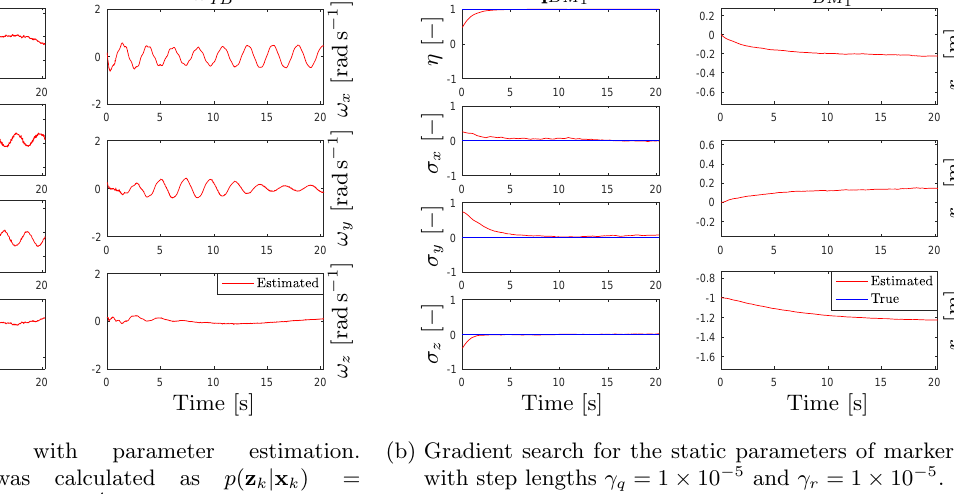
(a) Particle filtering with parameter estimation. (b) Gradient search for the static parameters of marker 1 with step lengths γ q = 1 × 10 − 5 and γ r = 1 × 10 − 5 .